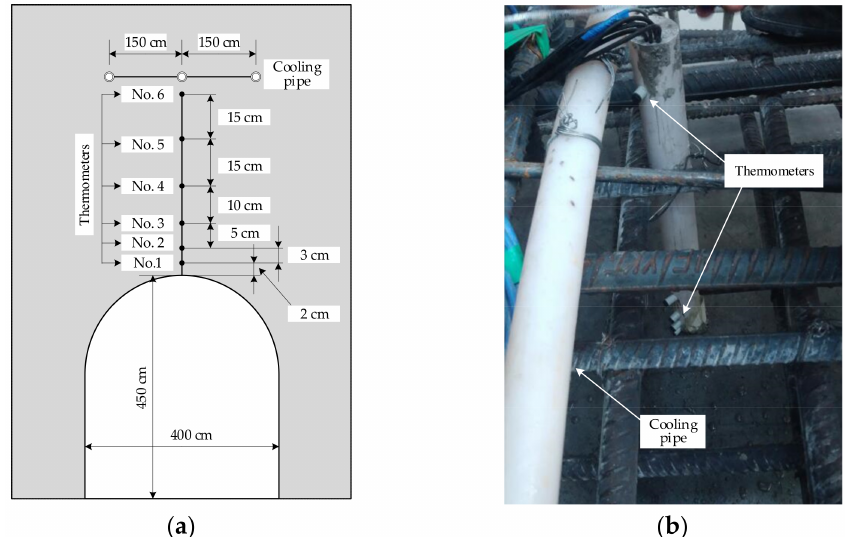
Figure 15. Arrangement of thermometers in gallery concrete: ( a ) design layout drawing; ( b ) actual buried thermometers.